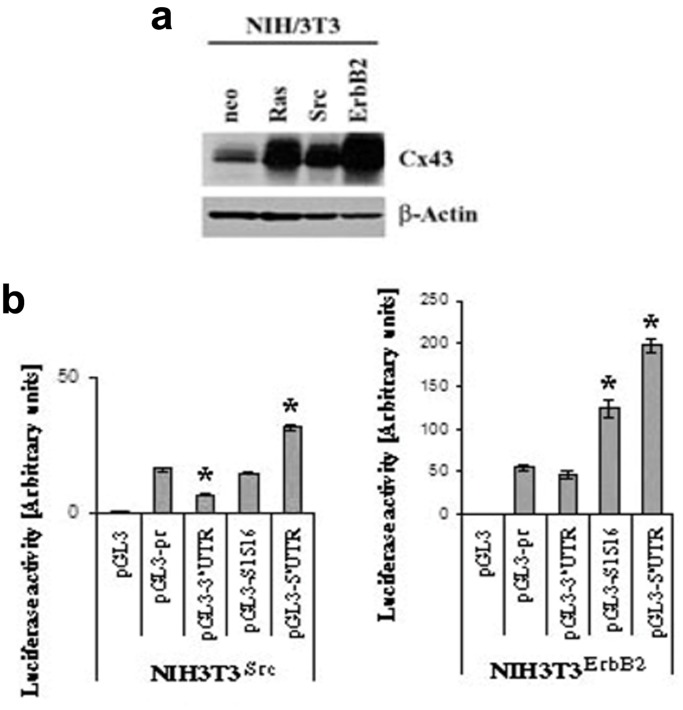
3′UTR and 5′UTR-driven effects in Src and ErbB2-transformed cells. a)
Western blot of the Cx43 expression in protein extracts from NIH3T3Neo, NIH3T3Ras, NIH3T3Src and NIH3T3ErbB2 cells. An antibody to β-Actin is used as a control for equal loading. b) Luciferase assay using the NIH3T3Neo, NIH3T3Src and NIH3T3ErbB2 cells transfected with various Cx43 mRNA 3′ and 5′UTR constructs. The experiments were performed at least three times in quadruplicates (*p<0.05).